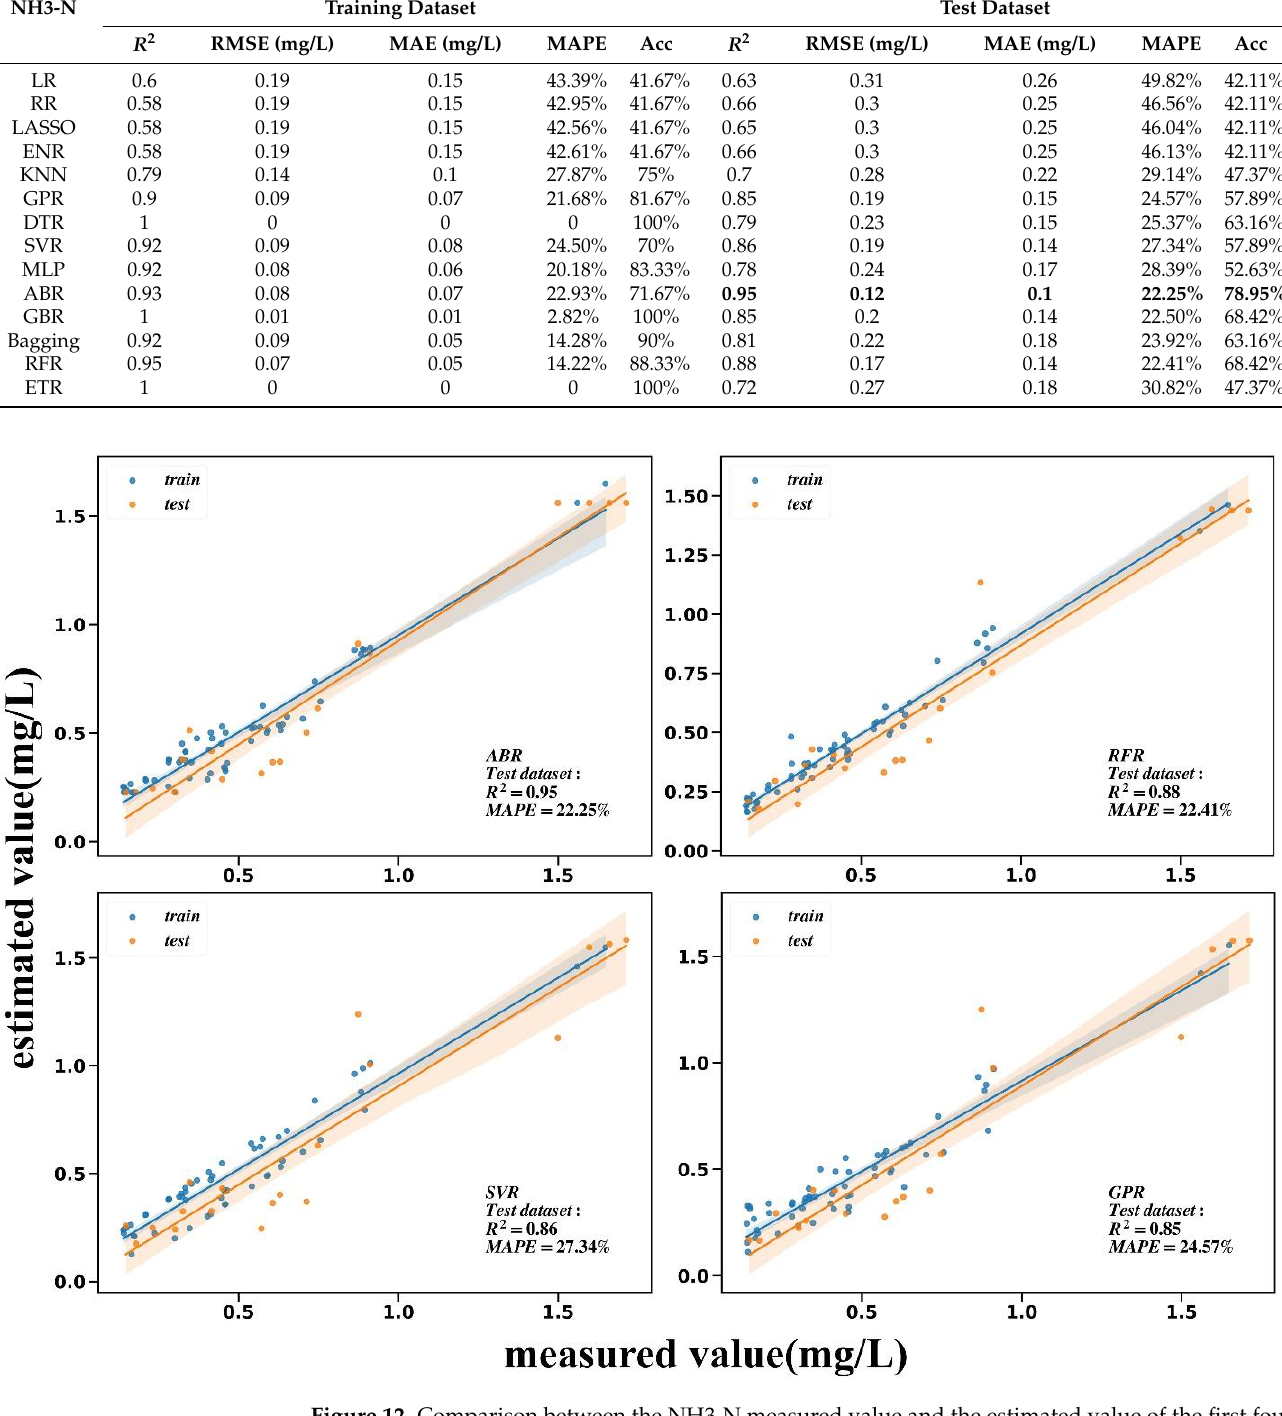
Table 8. Performance of fourteen models on DO training dataset and test dataset. DO